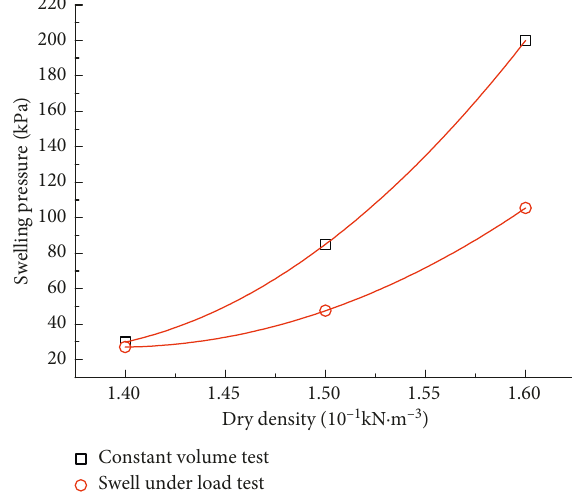
Figure 20: Relationship of expansive stress and dry density with same water content of 10.10% for two stress path